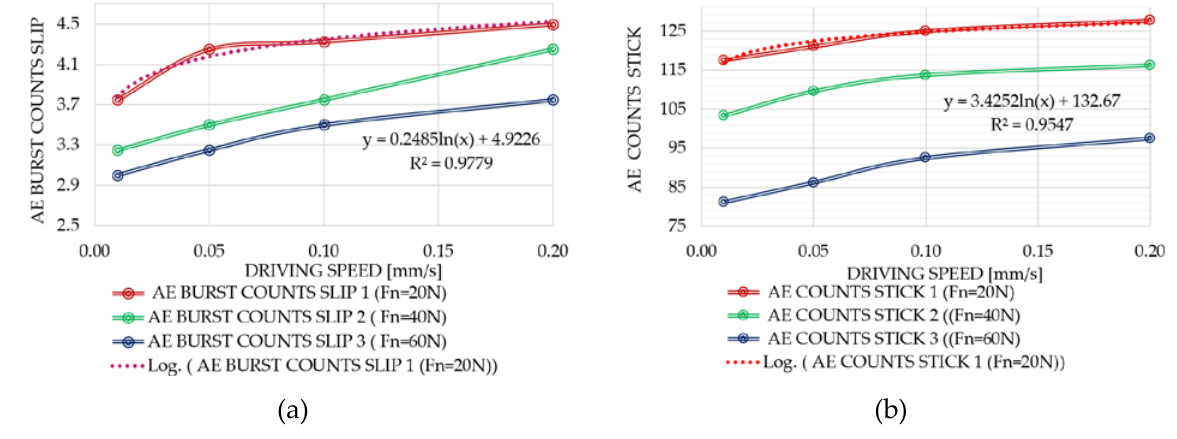
Figure 7. AE counts in the slip ( a ) and stick ( b ) phases, including the fitted curves of the counts of AE with a force of 20 N.